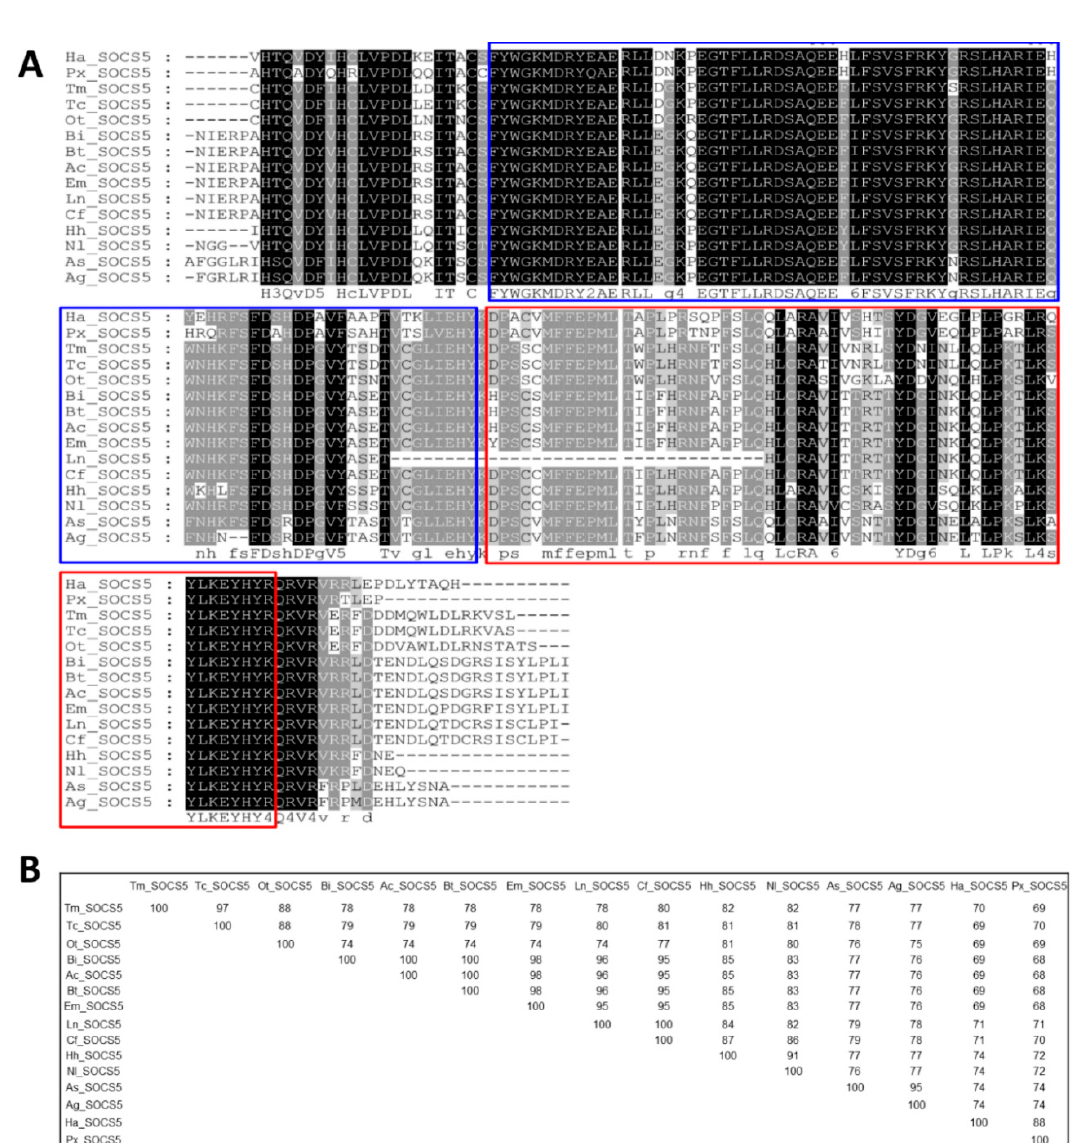
Figure 4. Alignment of TmSOCS5 to other SOCS5 proteins and percent identities. ( A ) Multiple sequence alignment of the SOCS5 C-terminal region of insect orthologs. The SH2 and SOCS box domains are shown in blue and red boxes, respectively. Identical residues in all sequences are shaded black, and well-conserved sequences are shaded grey. Deletions are indicated by dashes; ( B ) Percent identity matrix of TmSOCS5 and representative SOCS5 proteins. The analysis was performed by clustalX2 using representative amino acid sequences from Tribolium castaneum (XP_015833443.1), Plutella xylostella (XP_011566498.1), Helicoverpa armigera (XP_021196679.1), Onthophagus taurus (XP_022915891.1), Bombus impatiens (XP_012245047.1), Bombus terrestris (XP_012163125.1), Apis cerana (AEY61566.1), Eufrisea mexicana (OAD52276.1), Lasius niger (KMQ91264.1), Camponotus floridanus (EFN62367.1), Halyomorpha halys (XP_014279177.1), Nilaparvata lugens (XP_022206249.1), Anopheles sinensis (KFB35251.1), and Anopheles gambiae (ABV01933.1).